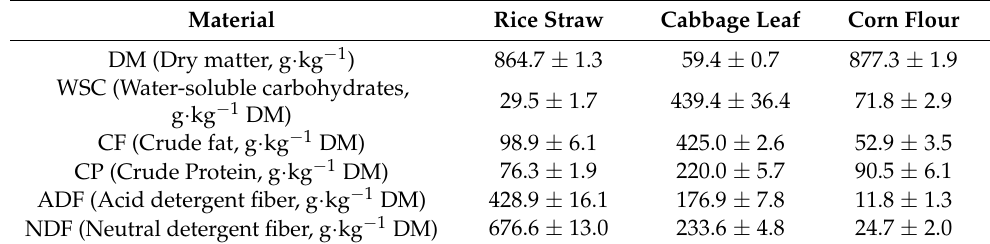
Table 1. The compositions of the raw materials. Material Rice Straw Cabbage